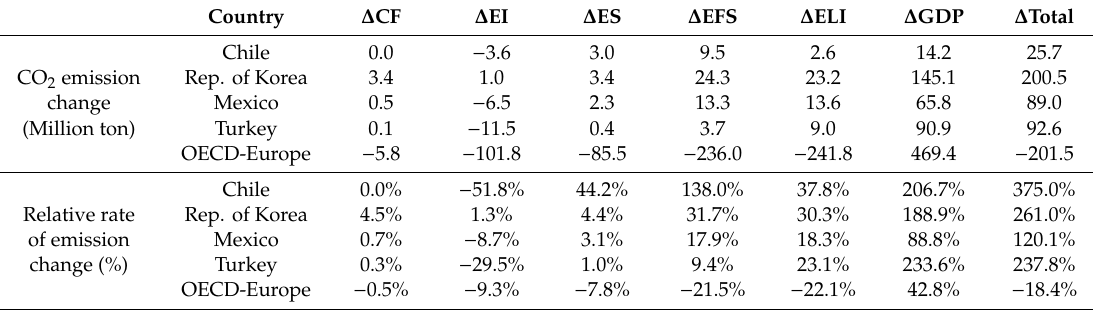
Table 4. The results of decomposition analysis of carbon emission growth countries,